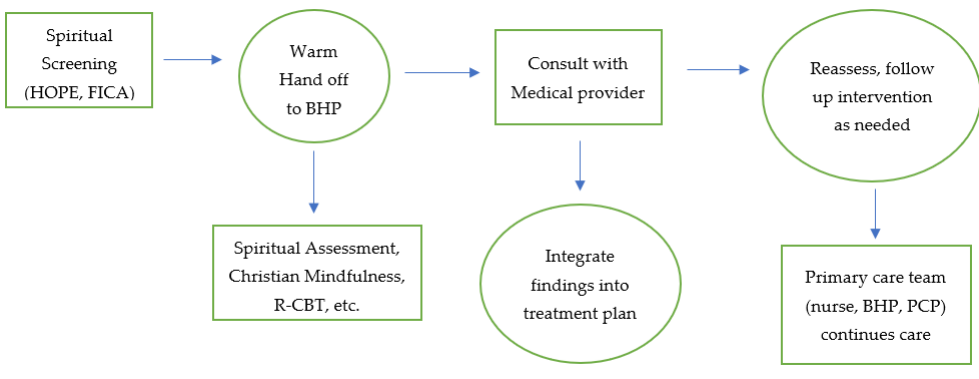
Figure 2. Workflow for the utilization of Christian mindfulness within PCBH.